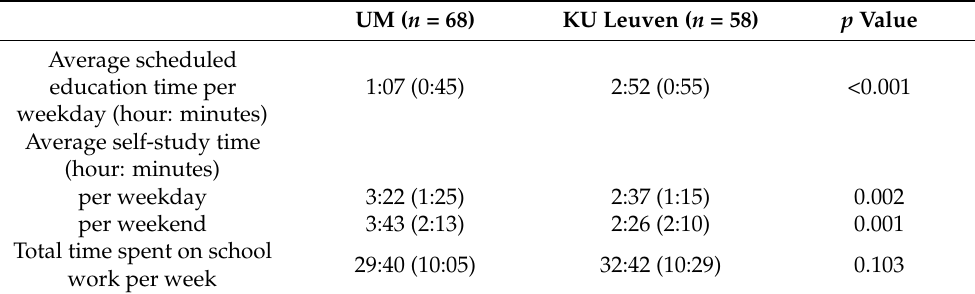
Table 2. Average scheduled education time during the weekdays and average self-study time on weekdays and weekends at UM and KUL.